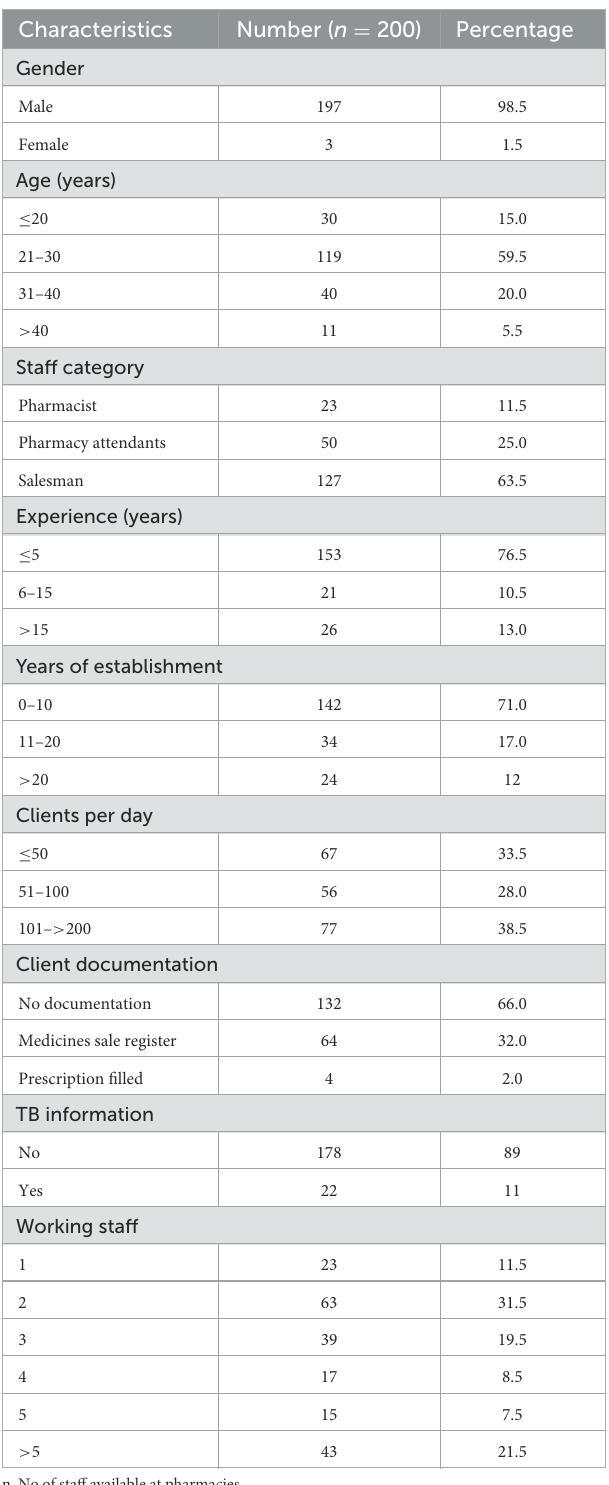
TABLE 2 Basic characteristics of working staff and selected pharmacies.